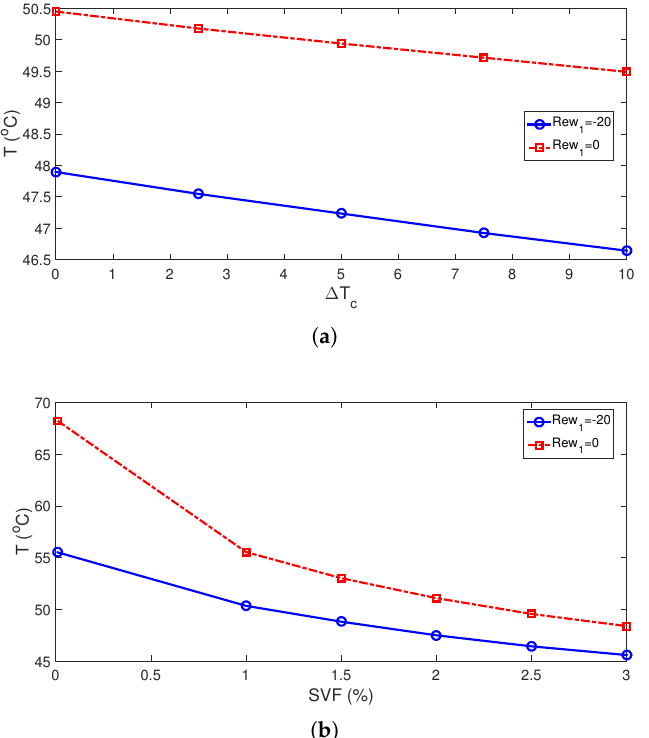
Figure 10. Average panel temperature for varying subcooled temperatures of RCCs (( a ), SVF=3%) and SVF of NPs ( ∆ T = 10, ( b )) ( ( Rew 1 ,Rew 2 ) = ( − 20, − 20 ) , Rc = 0.1H, Sc =